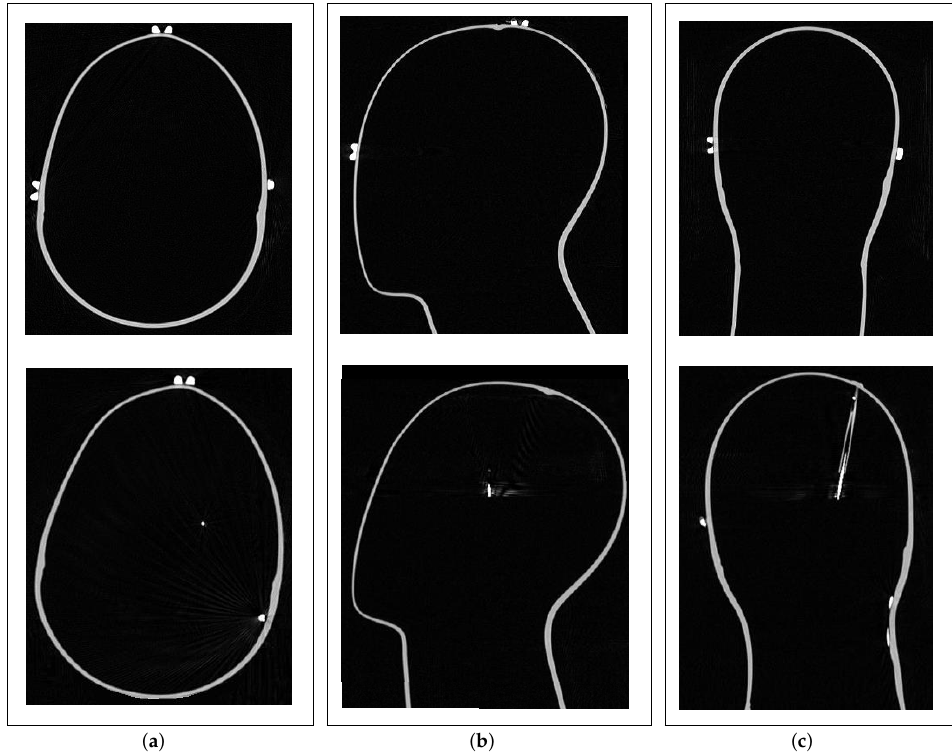
Figure 3. ( a ) Axial, ( b ) sagittal, and ( c ) coronal views of preoperative (upper row) and postoperative (lower row) CT imaging of the phantom. Preoperative imaging was used to create a 3D model of the phantom for an accurate electromagnetic model. Postoperative imaging was used to compare the results in electrode position and orientation detection with results from magnetic